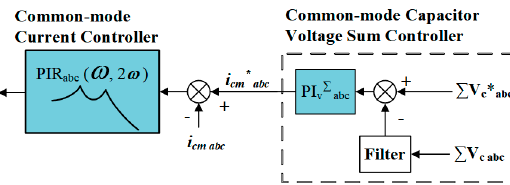
Figure 5. Diagram of internal control structure against inter-arm parametric imbalance (Scheme-B) [23].